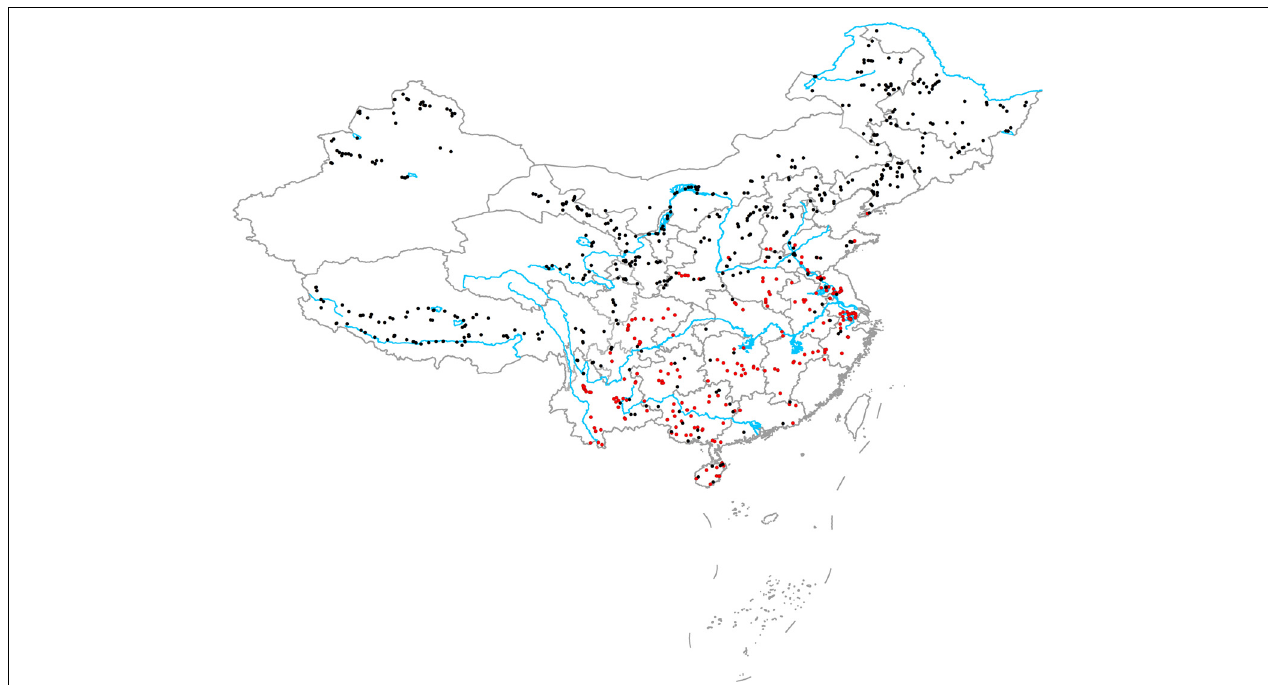
FIGURE 1 | Geographical locations of the sampling sites (red circles show the communities in which at least one exotic plant was present and black circles show the communities that did not have exotic plants).